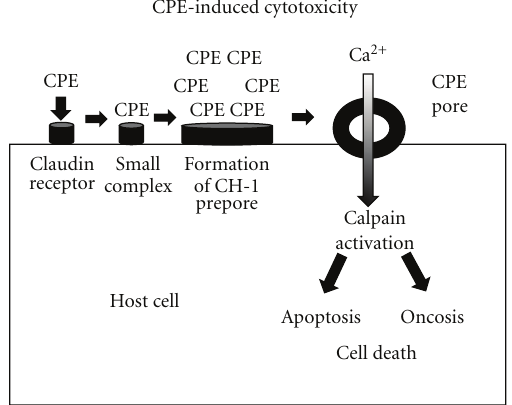
Figure 1: Model for CPE-induced cytotoxicity. CPE first binds to claudin receptors to form an ∼ 90 kDa small complex. Six small complexes are then thought to oligomerize on the membrane surface to form a CH-1 prepore. The prepore then inserts into membranes to form the active pore. This results in entry of calcium into cells, which activates calpain. When a high CPE dose is used, there is substantial entry of calcium into cells, causing a strong calpain activation; this results in cell death by oncosis. Lower CPE doses cause more limited calcium influx and thus a milder calpain activation; these cells die by classical caspase 3-mediated